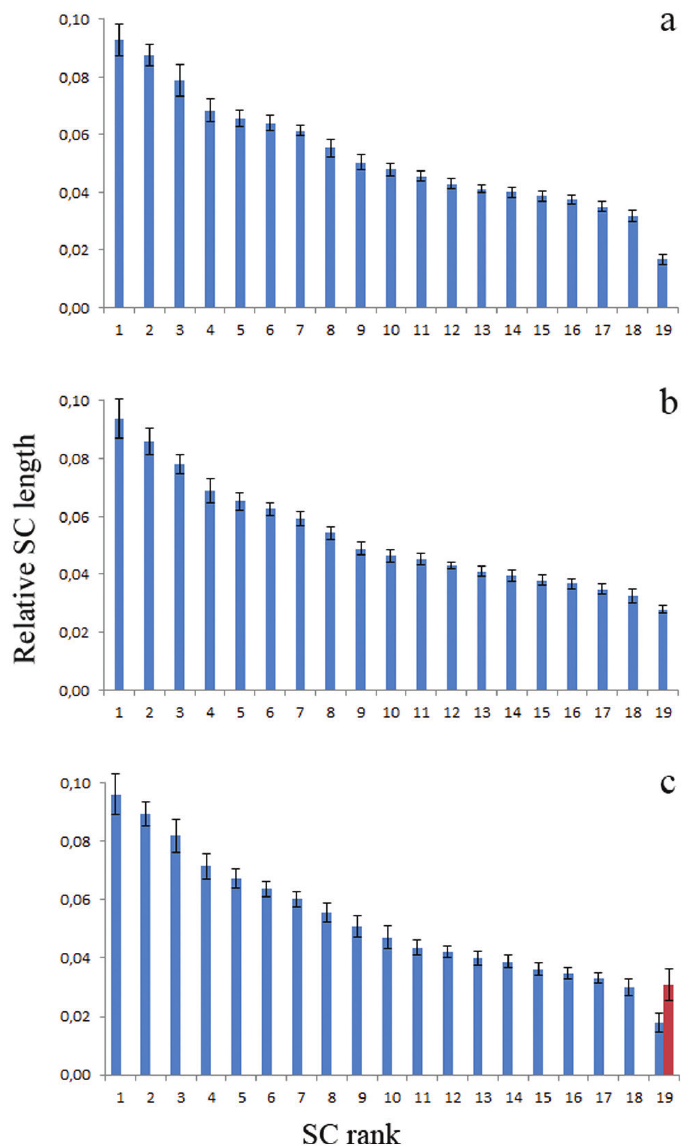
Figure 2. Relative lengths of the SCs in three sand lizards. a standard karyotype (21 spreads) b homozy- gote for the long variant of SC 19 (22 spreads) c heterozygote for the long variant of SC 19 (18 spreads). Red column: the long variant in the heterozygote. Bars show standard